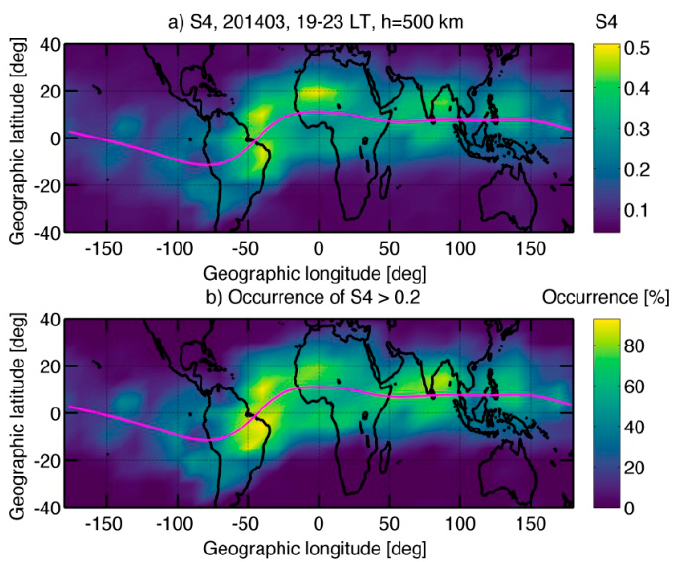
Figure 7. Global distribution of ( a ) S4 and ( b ) the occurrence of S4 > 0.2 at 500 km observed by COSMIC in March 2014. Magnetic equator is represented by a magenta line in every panel.